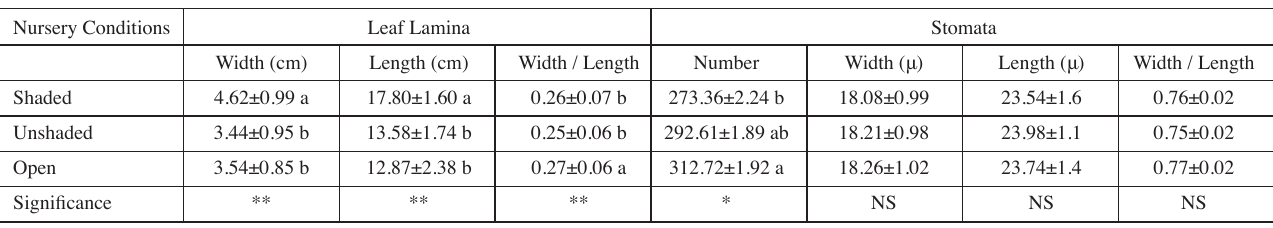
the chestnut (Tab. 1) and presented the mean data of temperature, light intensity and relative humidity of these nursery conditions (Fig. 1-3). But, we could not determine how responsible temperature, light intensity or relative humidity is for these